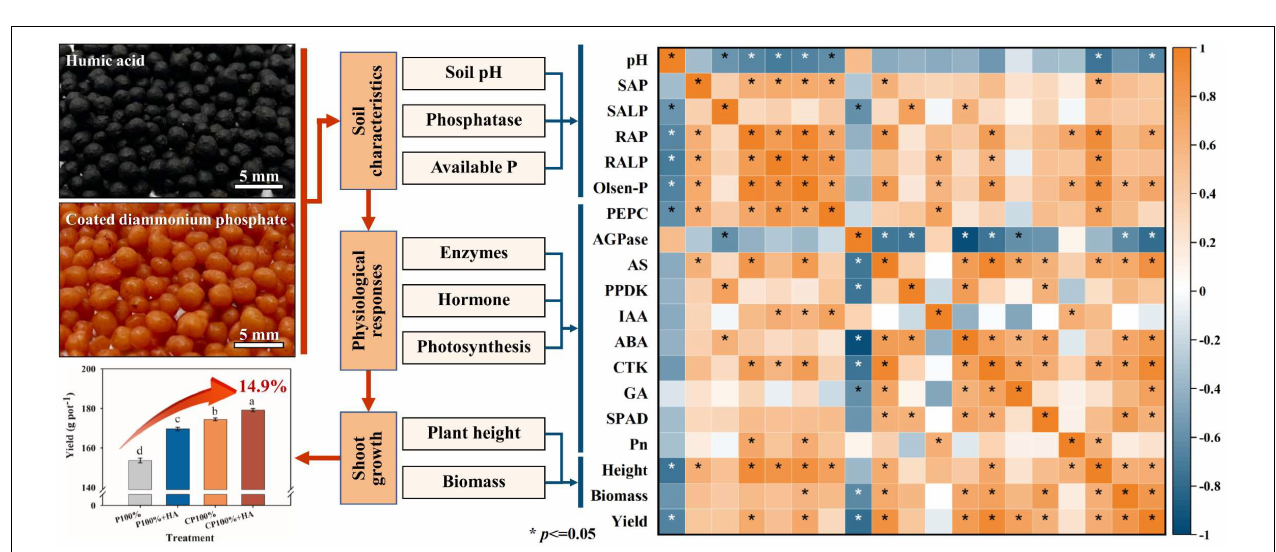
FIGURE 9 | Correlation relations between maize yield and different indices. Spearman’s correlation between soil variables, growth parameters, and maize yields. Blue represents negative correlation and red represents positive correlation. The darker the color, the stronger the correlation, and vice versa (* P ≤ 0.05). Height, plant height; SAP, soil acid phosphatase; SALP, soil alkaline phosphatase; RAP, root acid phosphatase; RALP, root alkaline phosphatase; Pn, photosynthetic rate; PEPC, Phosphoenolpyruvate carboxylase; AGPase, ADP-glucose pyrophosphorylase; PPDK, pyruvate phosphate dikinase; IAA, indole-3-acetic acid auxin; CTK, cytokinin; ABA, abscisic acid; GA,